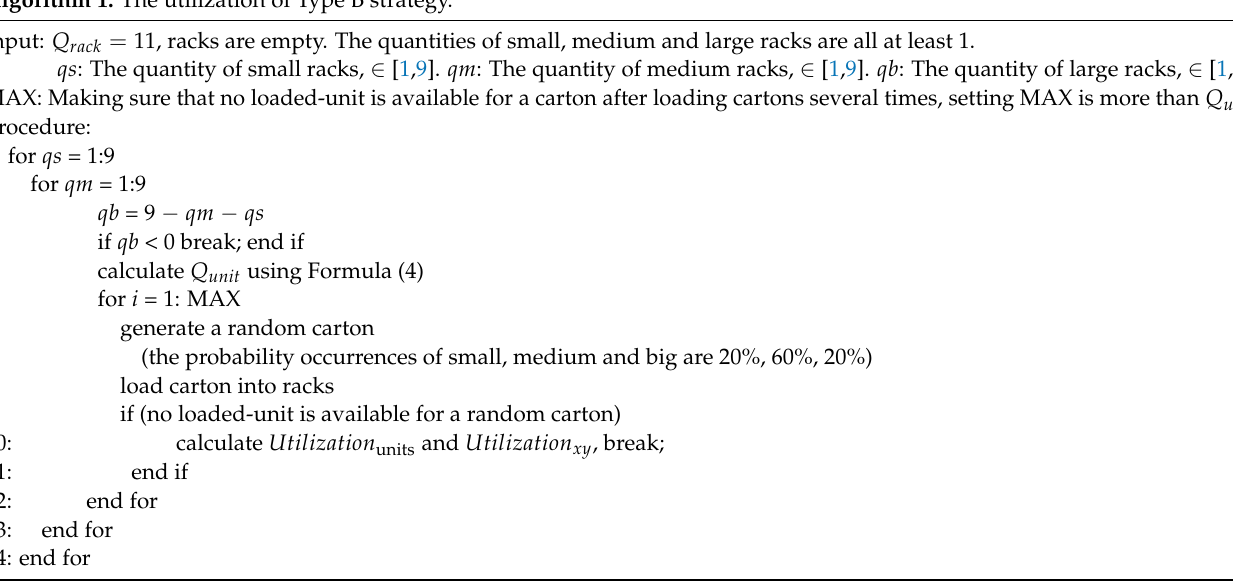
The process is shown in Algorithm 1, and using this algorithm, results are shown in Processes 2023 , 11 , x FOR PEER REVIEW Figure 10.